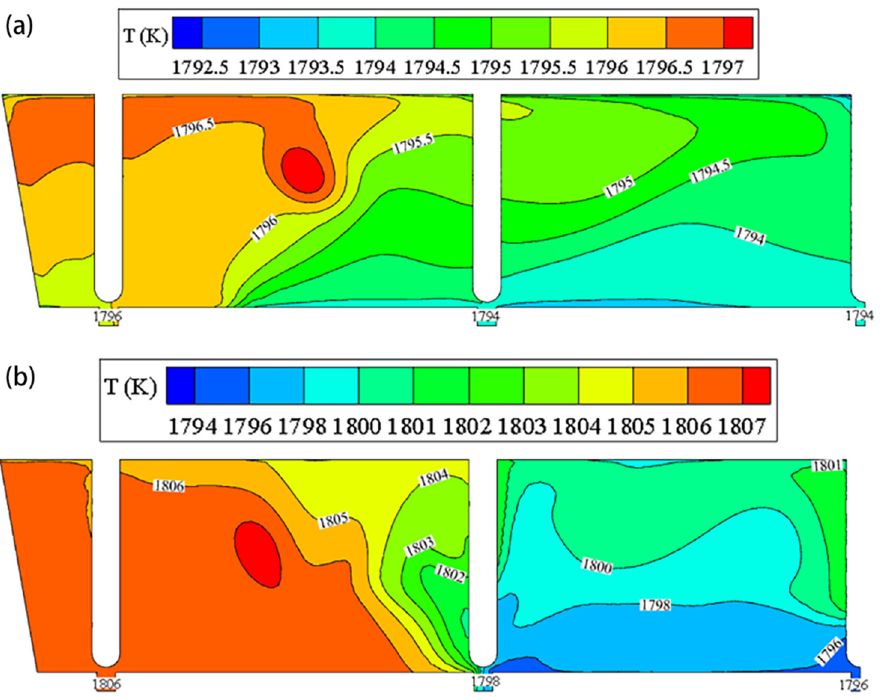
Figure 16. Temperature field at the plane passing through all outlet centers for case S0: ( a ) without induction heating; ( b ) with heating for 200 s at 1000 kW.